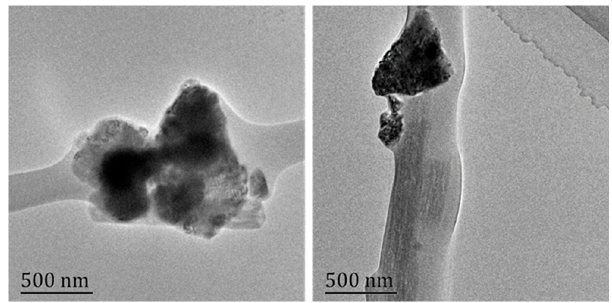
Figure 5. TEM images of PSCP5-NF.